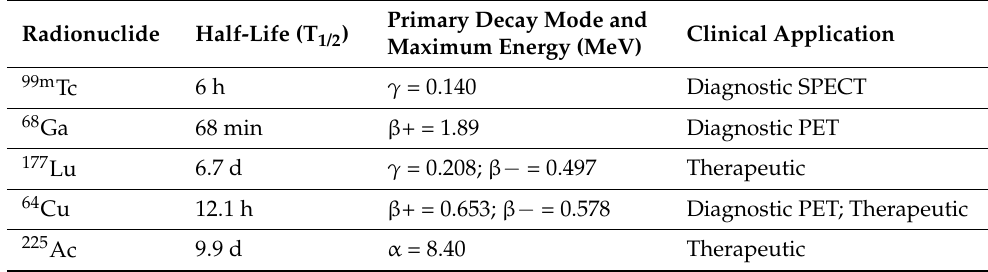
Table 1. Chemical and physical properties of radionuclides commonly used as radioimmunoconjugates. Primary Decay Mode and Radionuclide Half-Life (T 1/2 ) Clinical Maximum Energy (MeV)